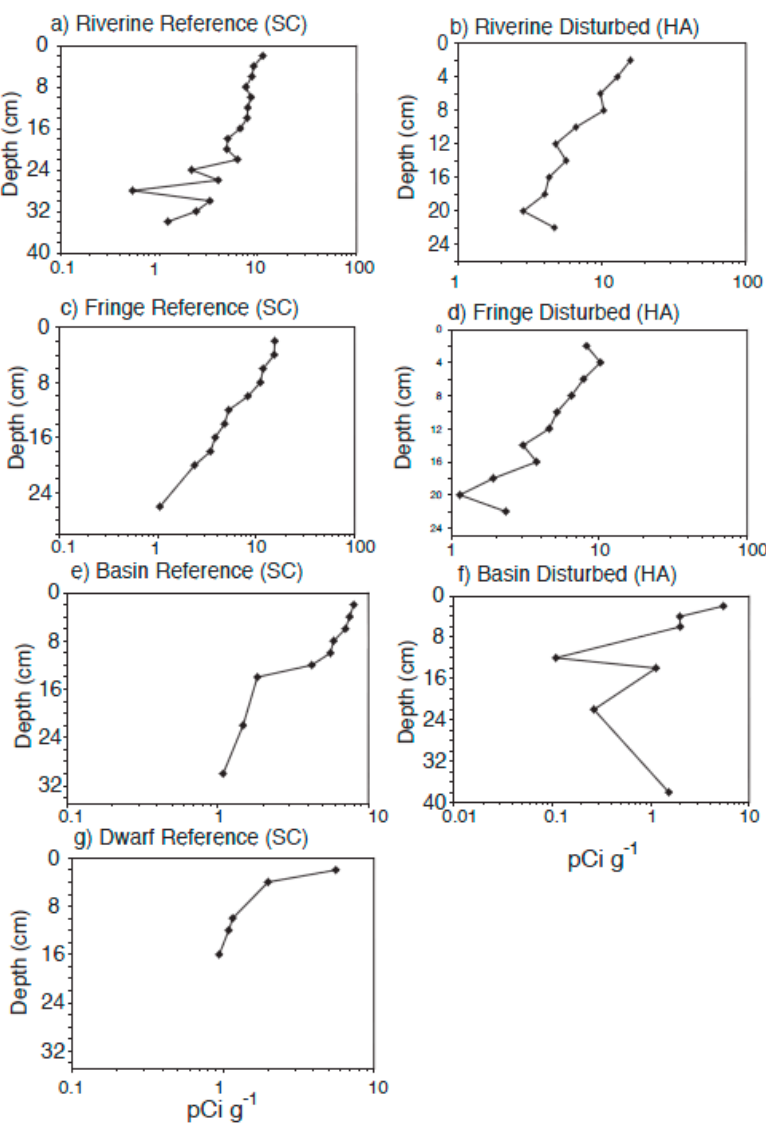
Figure 6. Lead-210 activity (pCi g −1 ) graphs with depth for estimating sedimentation in mangroves adjacent to Naples Bay. Figures are shown for ( a ) riverine reference mangroves; ( b ) riverine disturbed mangroves; ( c ) fringe reference mangroves; ( d ) fringe disturbed mangroves; ( e ) basin reference mangroves; ( f ) basin disturbed mangroves; and ( g ) dwarf reference mangroves.